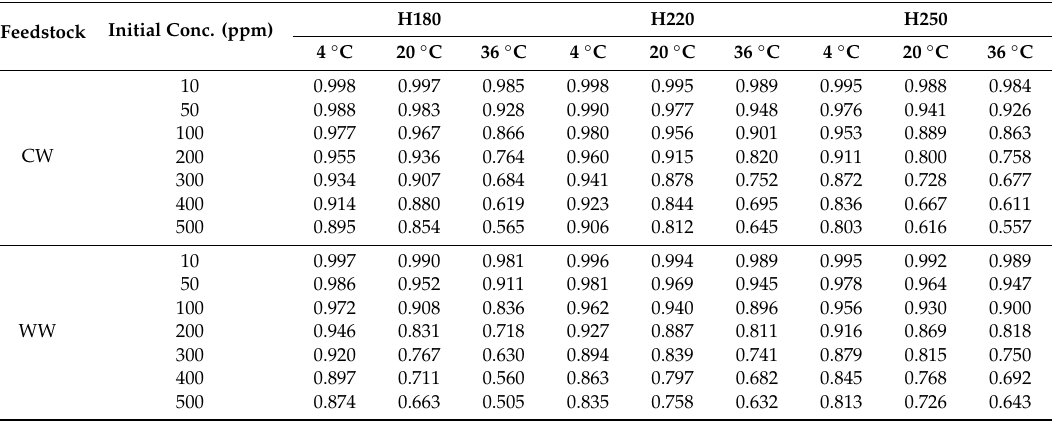
Table 4. Separation factor of the Langmuir model.